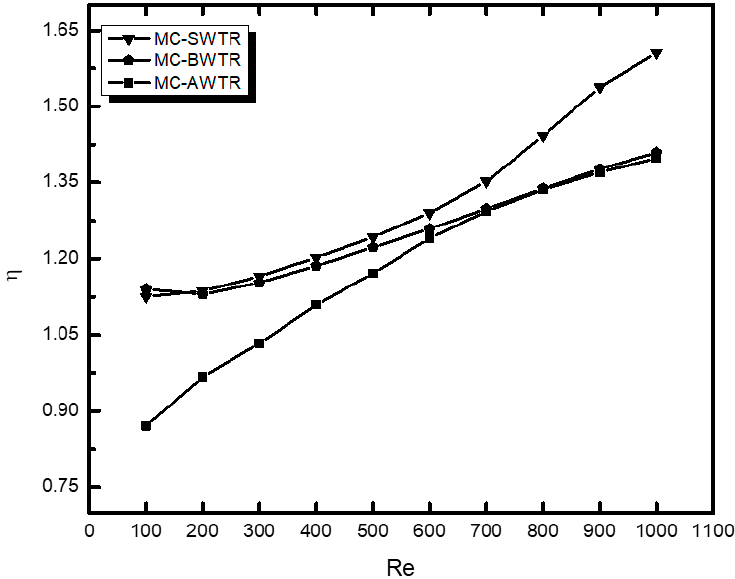
Figure 10. Comparison of thermal enhancement factor for different wall configurations MCHS.